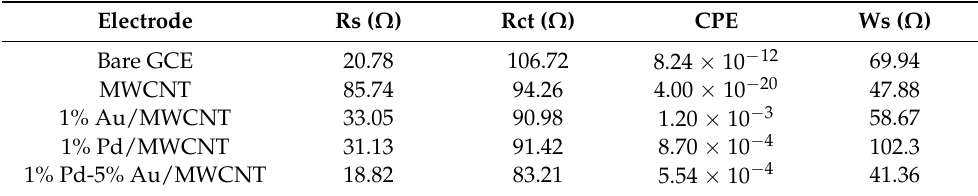
Figure 12. ( a ) Proposed electrochemical sensing mechanism for the as-prepared 1% Pd-5% Au/MWCNT; ( b ) electrochemical impedance spectroscopy (EIS) of the electrochemical behavior of different electrodes. Table 2. The simulated the elements value of the equivalence circuits of different sensing electrodes.